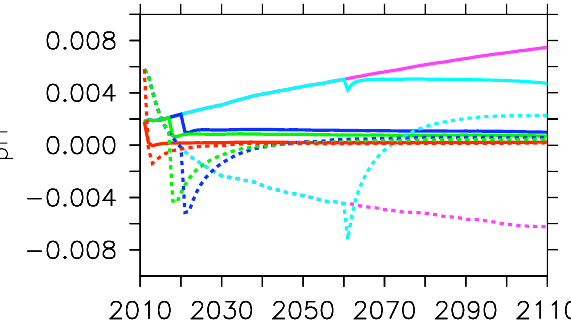
Fig. 8. Zonally averaged OIF-induced change in pH in year 2110 of the continuous fertilization experiment.